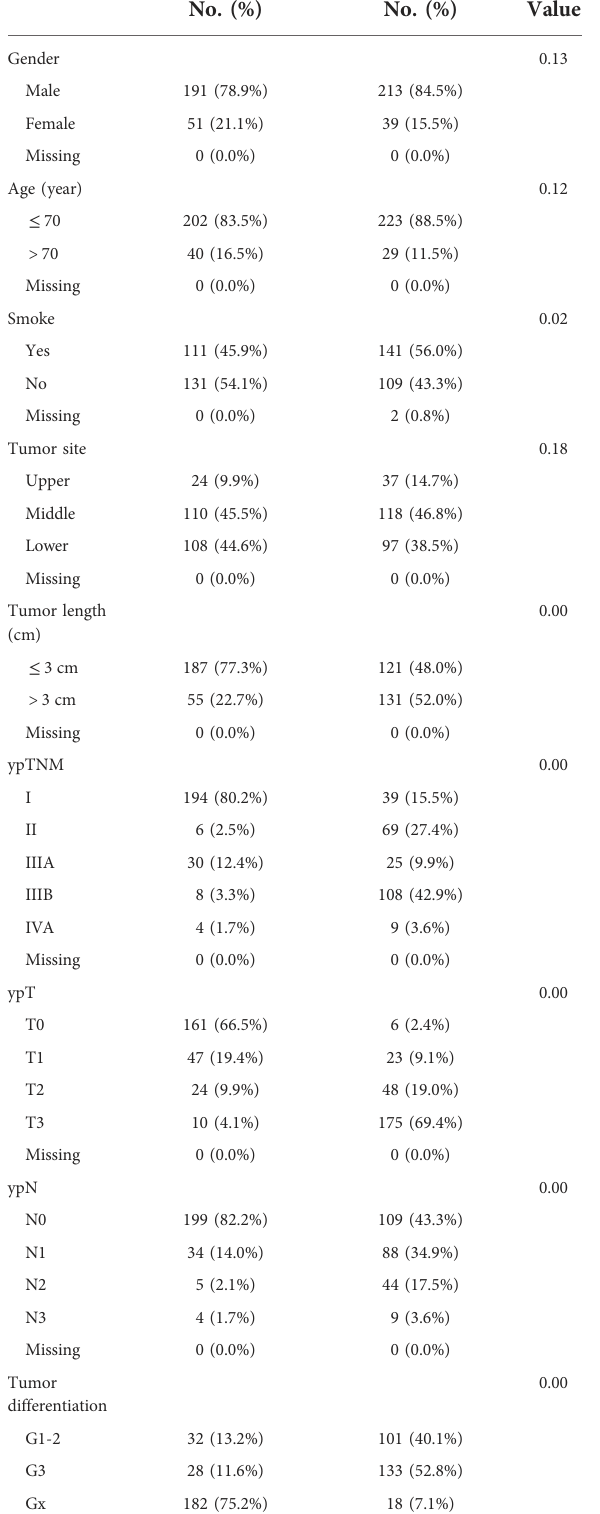
Cox regression analysis The results of univariate and multivariate